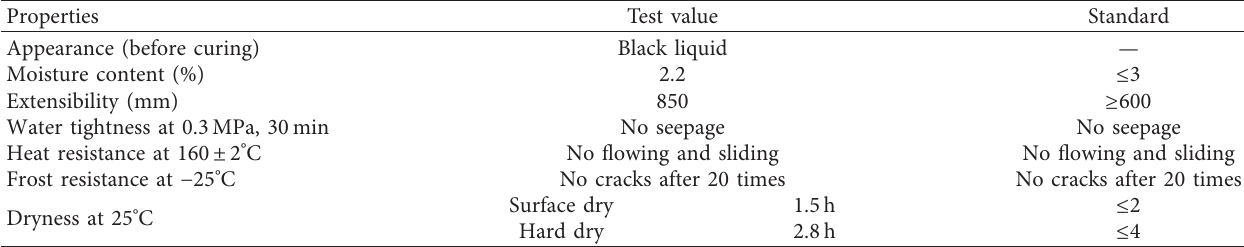
Table 3: Basic properties of the AMP-100 waterproof adhesive material.